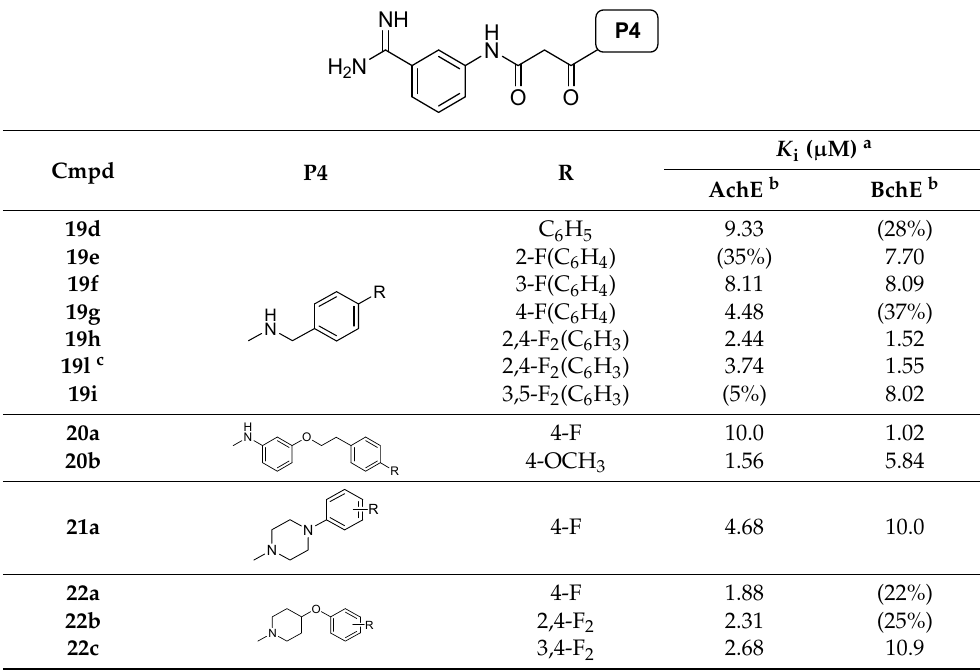
Molecules 2022 , 27 , x FOR PEER REVIEW Table 5. Inhibitory activity of selected malonamides on cholinesterases (eeAChE, eqBChE). Table 5. Inhibitory activity of selected malonamides on cholinesterases (eeAChE, eqBChE). Table 5. Inhibitory activity of selected malonamides on cholinesterases (eeAChE, eqBChE). Table 5. Inhibitory activity of selected malonamides on cholinesterases (eeAChE, eqBChE). H N H N Table 5. Inhibitory activity of selected malonamides on cholinesterases (eeAChE, eqBChE). Table 5. Inhibitory activity of selected malonamides on cholinesterases (eeAChE,